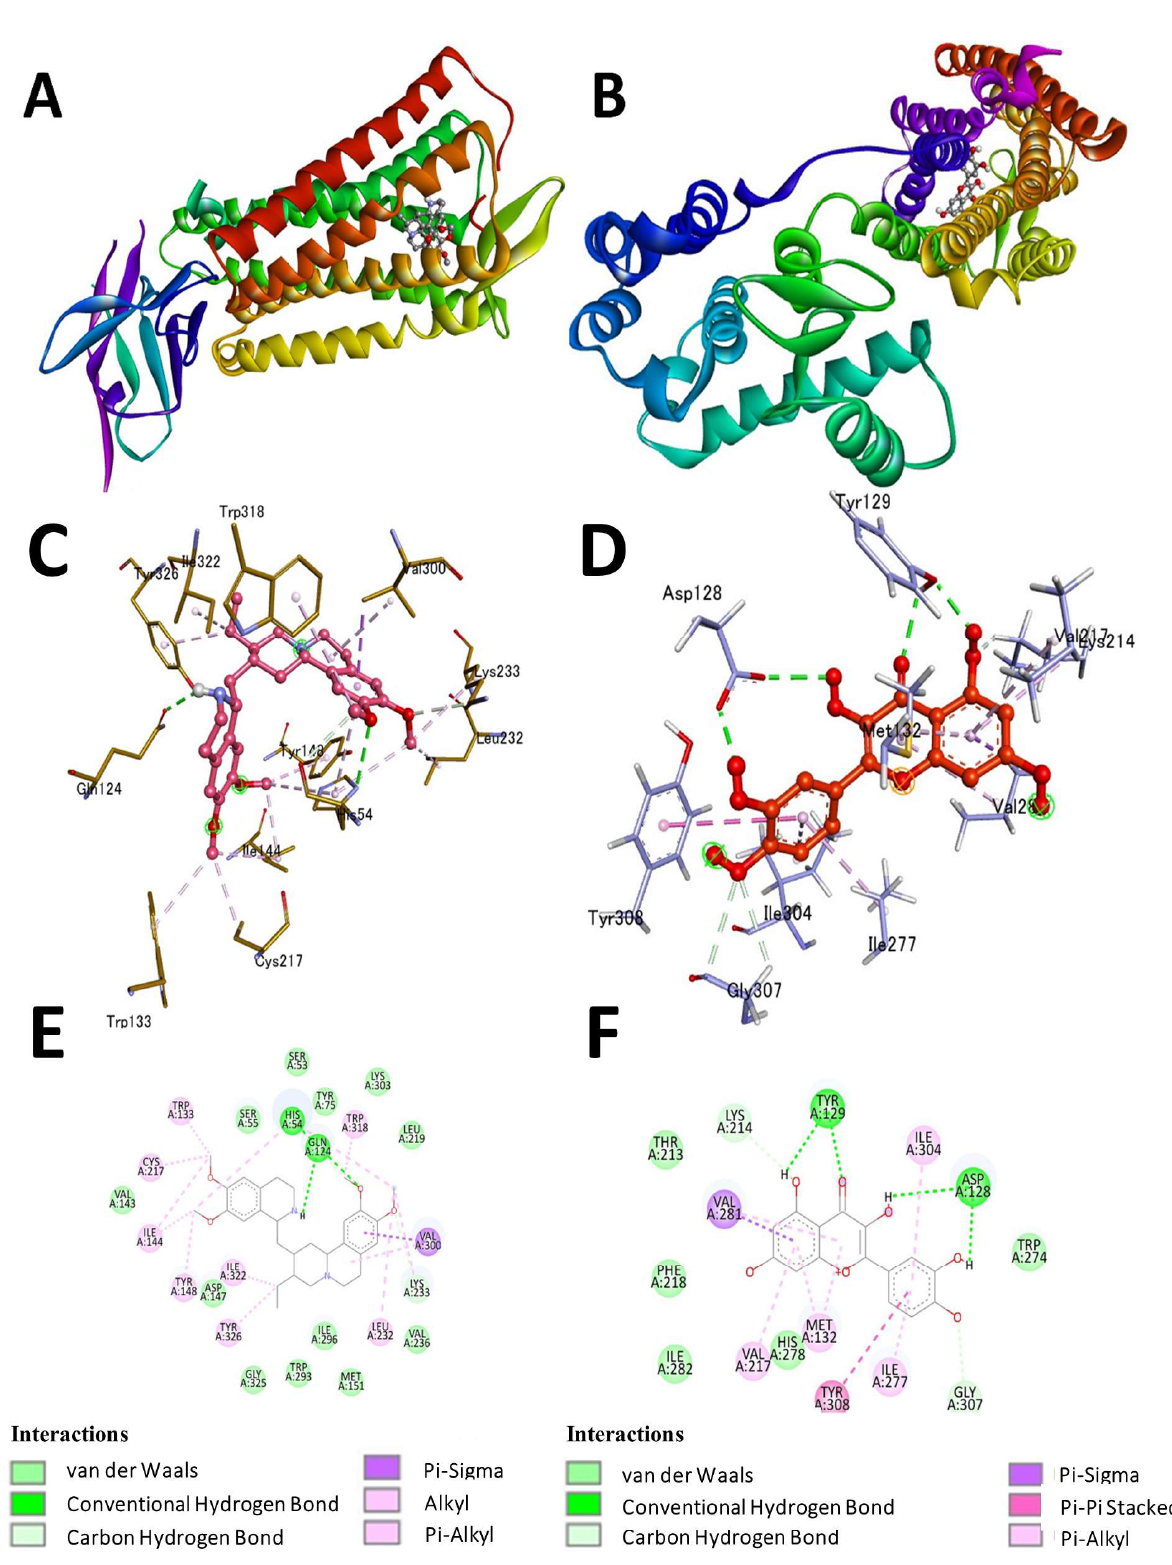
Figure 3. ( A ) 5C1M protein, ( B ) 4EJ4 protein, ( C ) the 3D interaction of emetine with 5C1M protein, ( D ) the 3D interaction of quercetin with 4EJ4 protein, ( E ) the 2D interaction of emetine with 5C1M protein, and ( F ) the 2D interaction of quercetin with 4EJ4 protein.